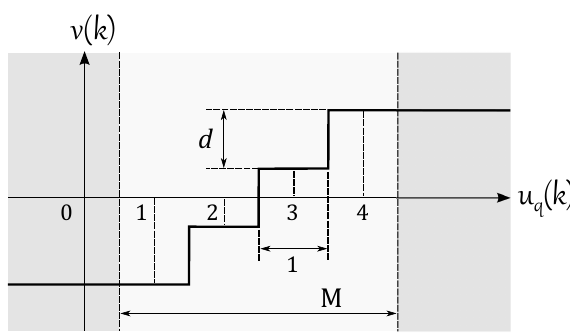
Figure 5. Example of static quantizer q [ · ] adapted for Q NNC ( M = 4).